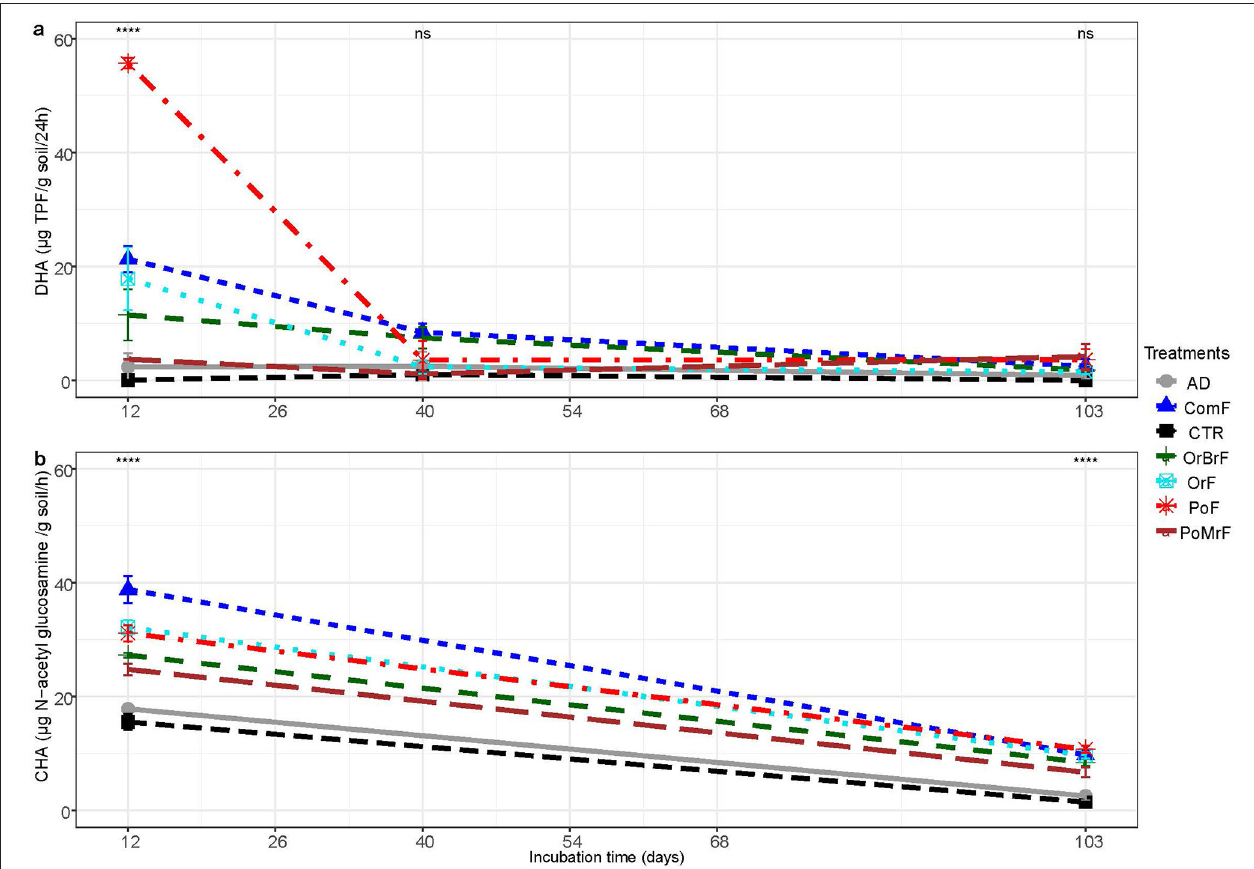
FIGURE 5 | Mean dehydrogenase (A) and chitinase (B) enzyme activities at a selected period of incubation ( n = 3 ± SE). **** and ns refer to statistically significant differences ( p < 0.001) and no significant difference ( p >